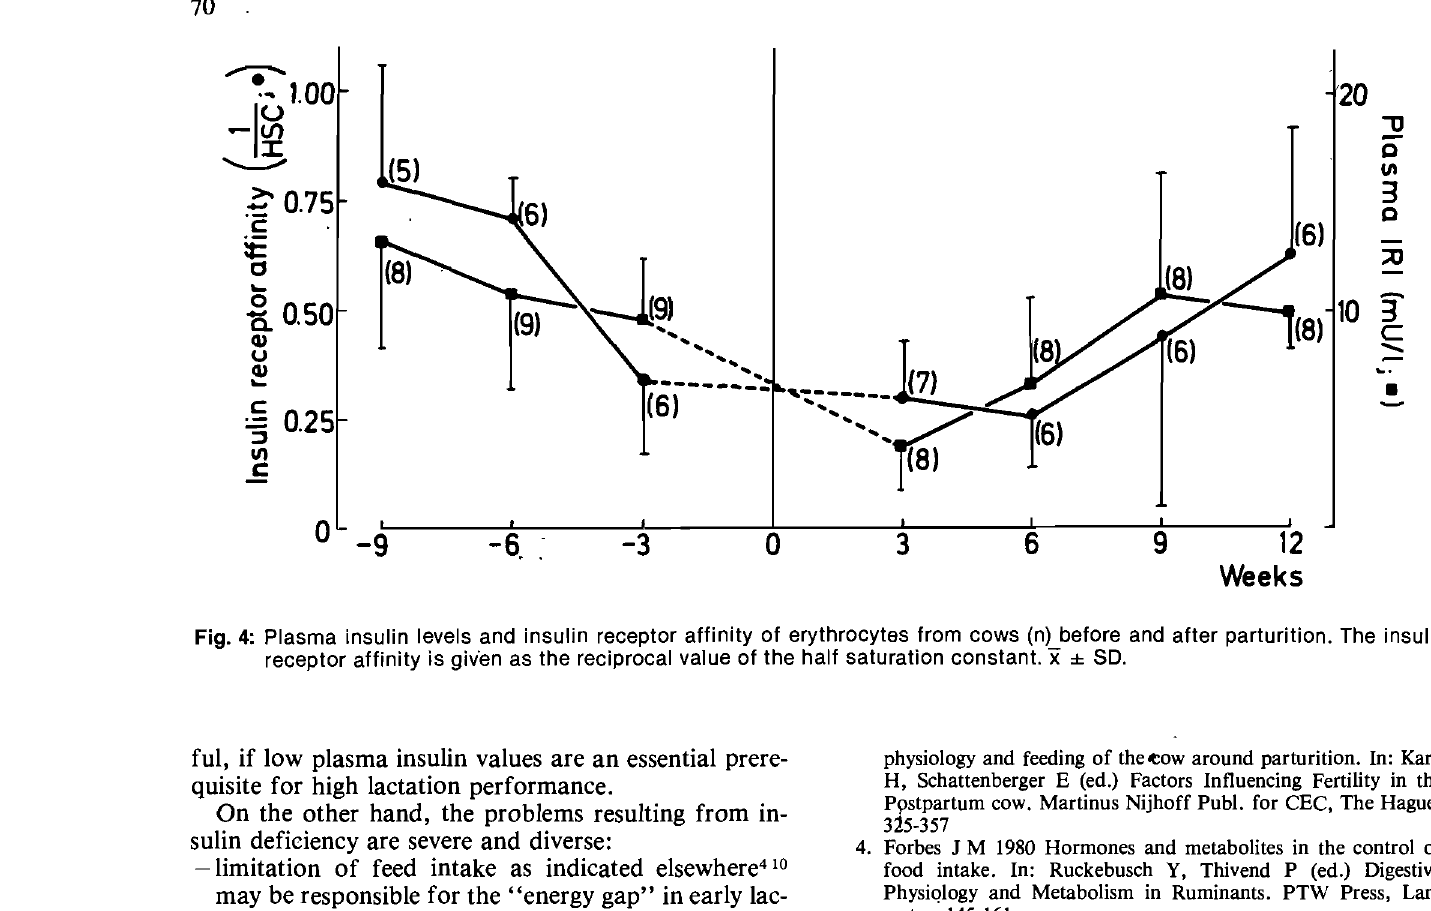
quisite for high lactation